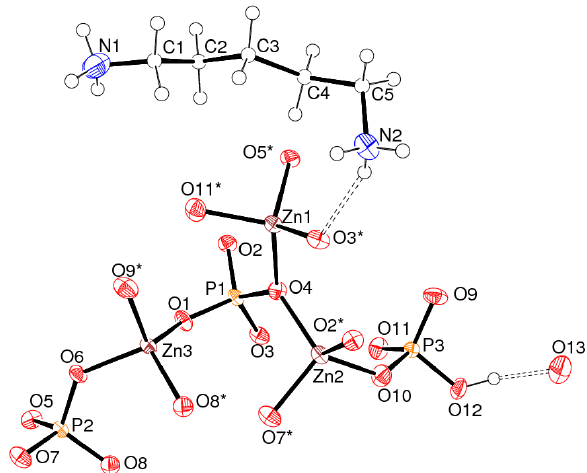
Symmetry codes as Table 1; additionally: (#5) ½+ x , y −½, z ; (#6) − x , y +1, − z ; (#7) ½− x , ½+ y , − z ; (#8) − x , y , − z ; (#9) ½− x , ½+ y , 1− z